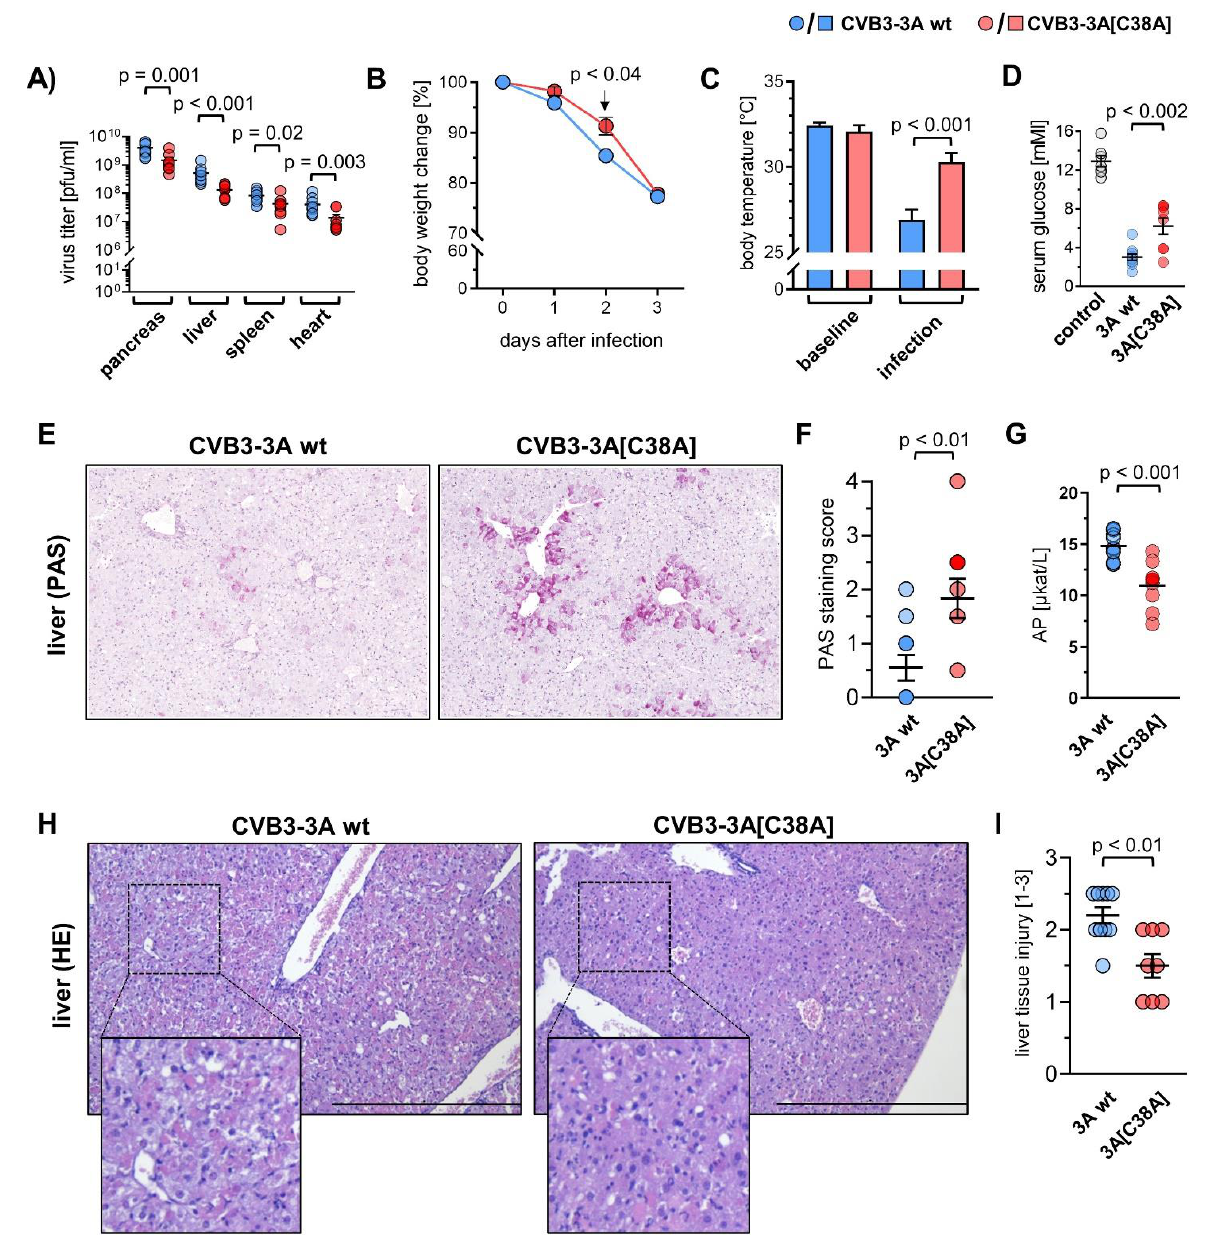
Figure 4. Mitigation of virus-triggered liver pathology by the CVB3-3A[C38A] mutant. Male C57BL/6 mice were infected intraperitoneally with 1 × 10 5 pfu of CVB3 (wt) encoding wt protein 3A or 3A[C38A] and sacrificed at day 3 after infection ( n = 10 for each virus strain). ( A ) Virus titers in indicated tissues were determined by a plaque assay. ( B ) Normalized body weight change (day 0 = 100%) at each day after infection. ( C ) Body temperature at baseline and 3 days after infection. ( D ) Serum glucose levels at baseline (control) and 3 days after infection. ( E ) Periodic acid-Schiff (PAS) staining of liver sections. ( F ) Graph depicts scoring of staining intensity (0 – 4, 0 = PAS-negative cells, 4 = PAS-positive cells). ( G ) Serum alkaline phosphatase levels 3 days after infection ( n = 10 per group). ( H ) Hematoxylin-eosin staining of liver sections. ( I ) Liver pathology was categorized based on the severity of inflammation and necrosis using the following scoring system: 0: no inflammation/ necrosis; 1: scattered immune cells/mild necrosis (<10%); 2: immune cell foci/marked necrosis (10 – 50%); 3: diffuse immune cell infiltrates/severe necrosis (>50%), according to [23]. Unpaired t -test with the exception of ( B ) and ( C ), analysis by 2-way ANOVA with Sidak post hoc test.